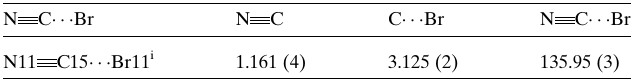
Table 1 Contact geometry (A˚ , (cid:3) ).